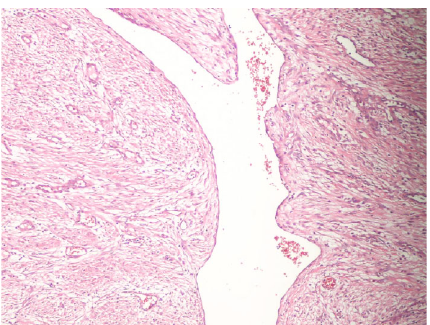
Figure 3: Hematoxylin and eosin stain (H&E) showing the proliferation of fi brous tissue with abundant variably sized vascular channels interspersed among the spindle cells in background, consistent with the diagnosis of angio fi broma (10x).